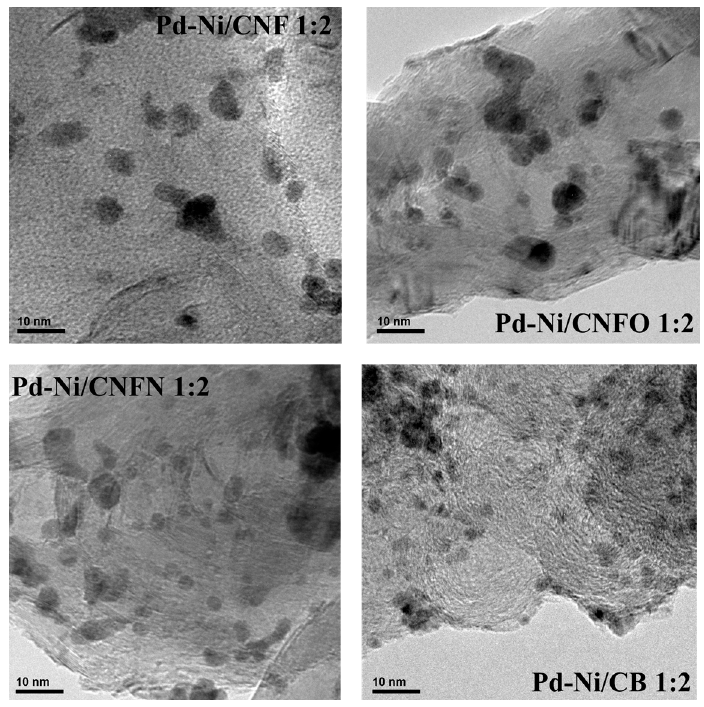
Figure 4. Transmission electron microscopy analysis (TEM) images of the synthesized Pd ‐ Ni catalysts. Table 2. Physical characterization of Pd ‐ Ni catalysts.